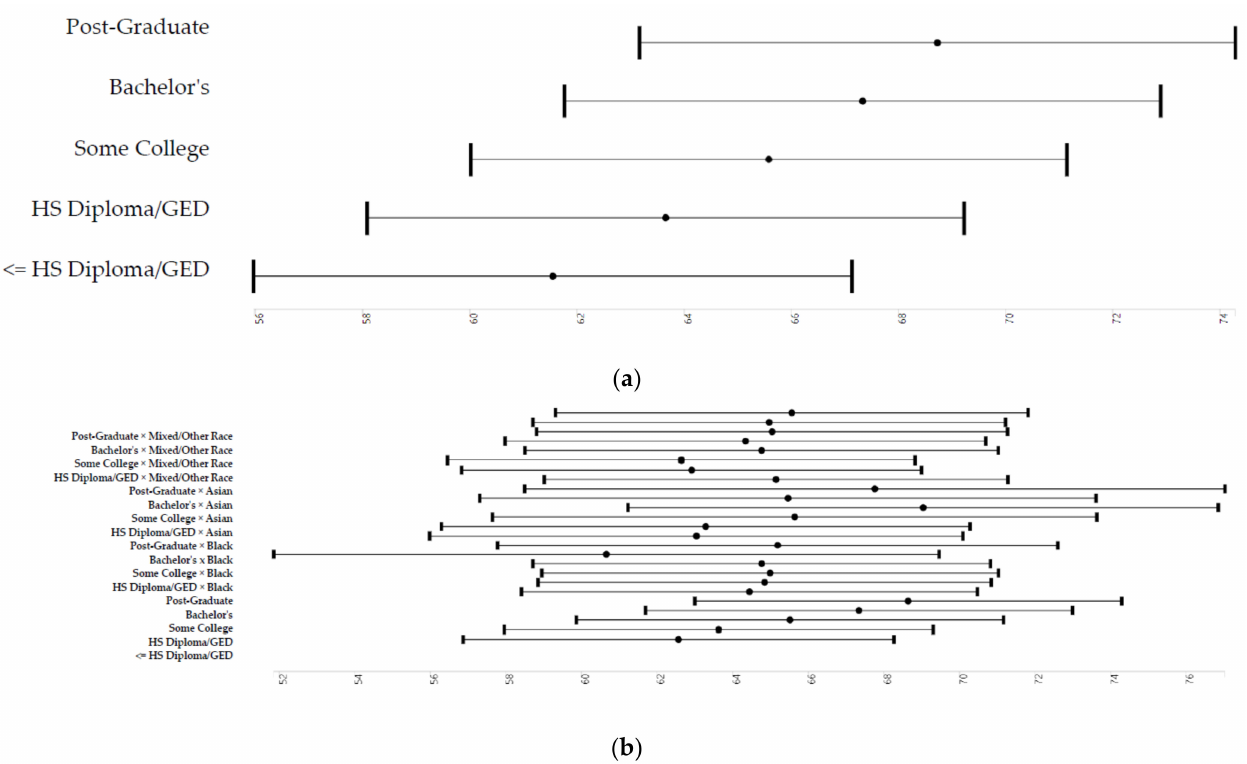
Figure A8. Association between parental education and children’s reading ability. In these figures, X represents children’s reading ability and Y represents parental education across racial groups. ( a ) Overall; ( b ) by